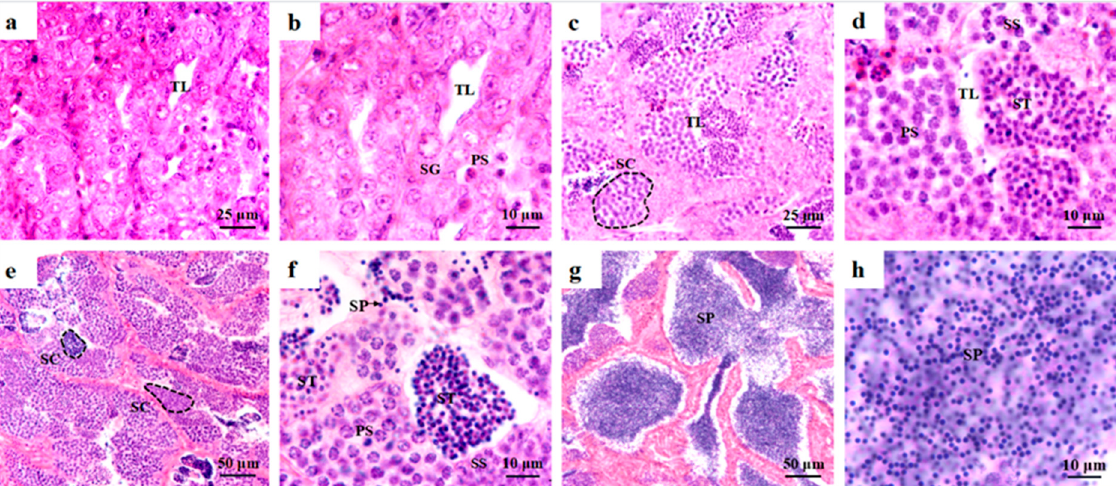
Figure 1. Histological observations of stage Ⅱ – Ⅴ testes in O. bidens. ( a ) Stage Ⅱ testis. The seminifer- ous tubules have been formed with some small tubule lumens; ( b ) Enlarged image of ( a ). Spermat- ogonia and primary spermatocytes exist. ( c ) Stage Ⅲ testis; ( d ) Enlarged image of ( c ). The testes are mainly composed of primary spermatocytes and include some of spermatogonia, secondary spermatocyte, spermatid. ( e ) Stage Ⅳ testis. Spermatids cysts increased, some sperm cysts burst, and spermatozoa flew into tubule lumen; ( f ) Enlarged image of ( e ). The testes are mainly composed of spermatocytes, spermatid and spermatozoa. ( g ) Stage Ⅴ testis. Most sperm cysts opened, and spermatozoa were released into lumen of seminiferous tubule. ( h ) Enlarged image of ( g ). Mostly sper- matozoa can be observed. SG: spermatogonia; PS: primary spermatocyte; SS: secondary spermato- cyte; ST: spermatid; SP: sperm; SC: spermatogenic cyst; TL: tubule lumens.